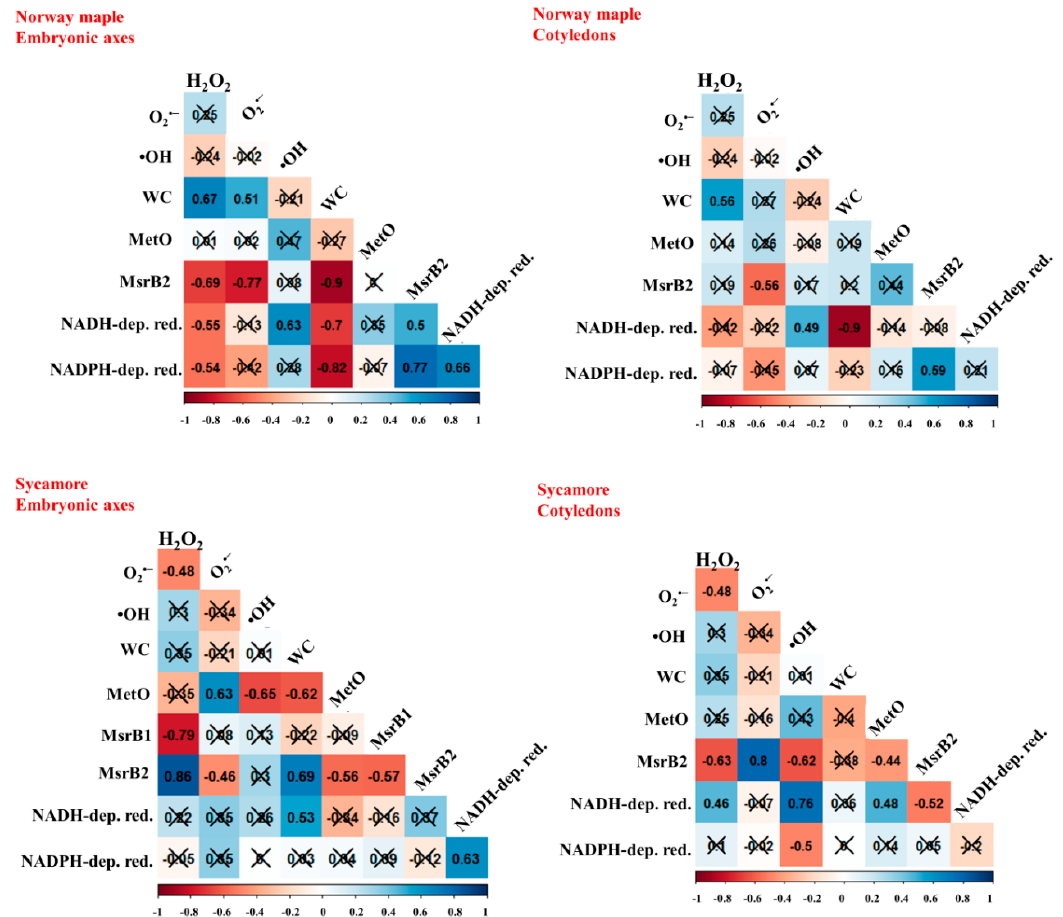
Figure 8. Correlation matrices calculated for embryonic axes and cotyledons of Norway maple and sycamore dry and germinating seeds based on levels of hydrogen peroxide (H 2 O 2 ), superoxide anion radical (O 2 •− ) and hydroxyl radical ( • OH), water content (WC), levels of protein-bound methionine sulfoxide (MetO), the abundance of methionine sulfoxide reductase isoforms (MsrB1, MsrB2), activity of NADH-dependent reductases (NADH-dep. red.), activity of NADPH-dependent reductases (NADPH-dep. red.). The percentage of WC was ArcSin transformed. Crossed numbers indicate non-significant correlation ( p > 0.05). Th more red color the more negative correlation, whereas the more blue the more positive correlation.